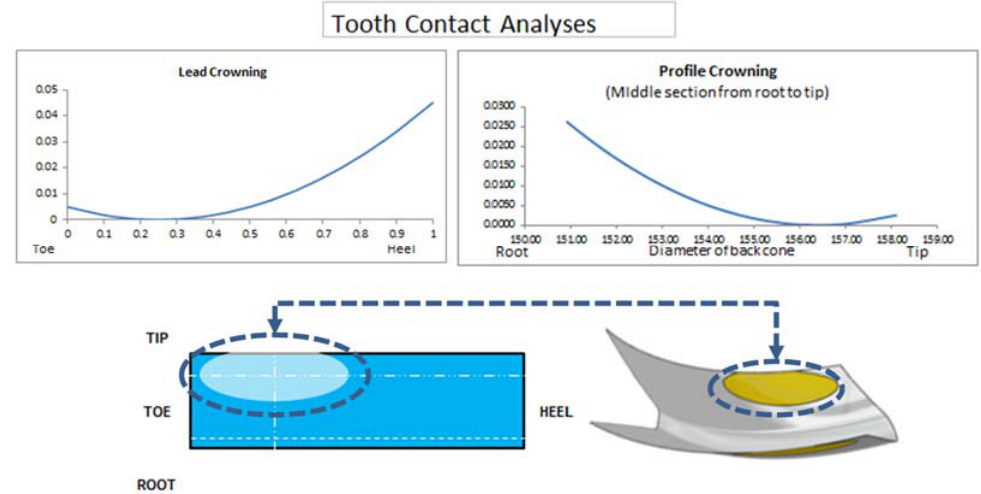
Figure 4. Gear tool contact analysis example, obtained from software.